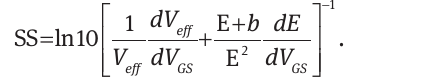
- V ) of a MOSFET [28] and a TFET showing a DS GS